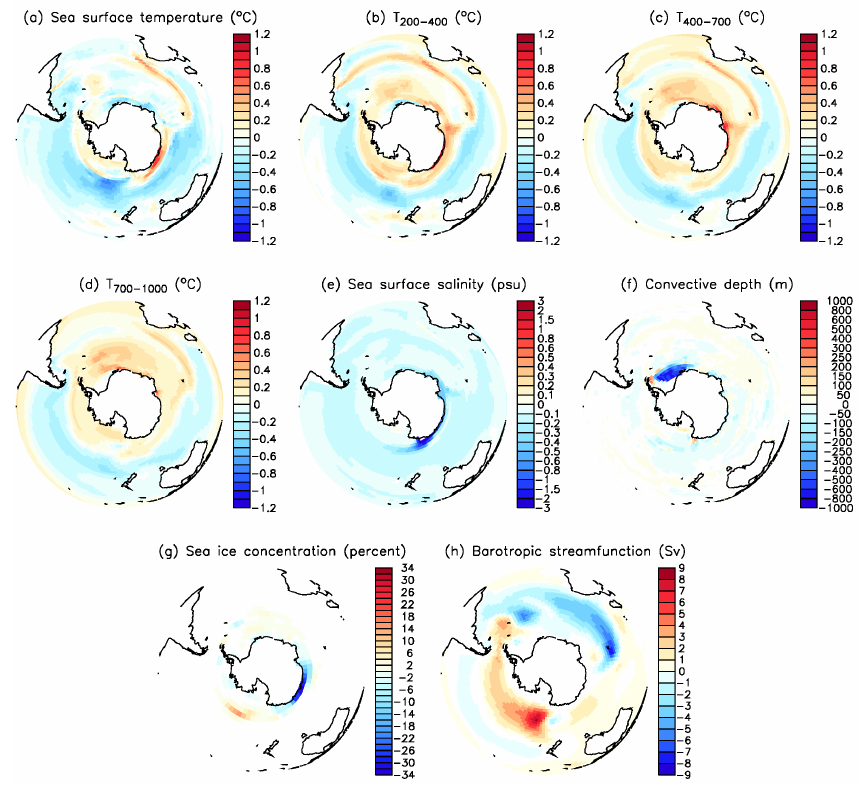
Figure 5. Mean anomalies for the final 100 years of the hosing phase (i.e. years 801–900) of experiment WILKES, relative to the equivalent years of the pre-industrial control simulation: (a) sea surface temperature ( ◦ C), (b) mean temperature at a depth of 200–400m ( ◦ C), (c) mean temperature at a depth of 400–700m ( ◦ C), (d) mean temperature at a depth of 700–1000m ( ◦ C), (e) sea surface salinity (psu), (f) convective depth (m), (g) sea ice concentration (%) and (h) barotropic streamfunction (Sv). Only values that are significant at the 5% probability level are